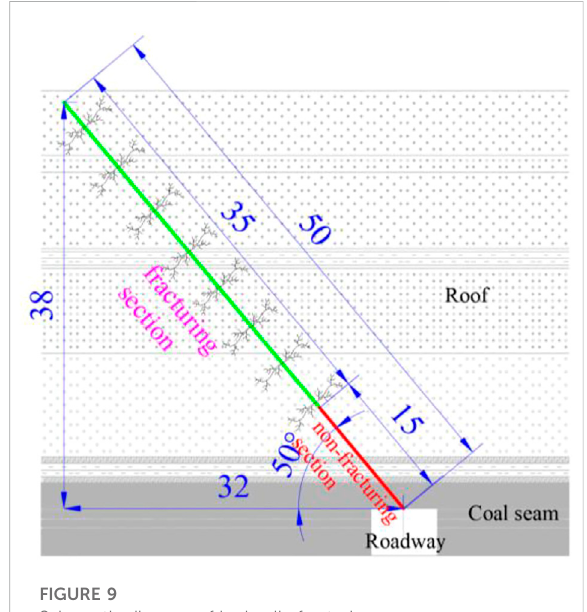
FIGURE 9 Schematic diagram of hydraulic